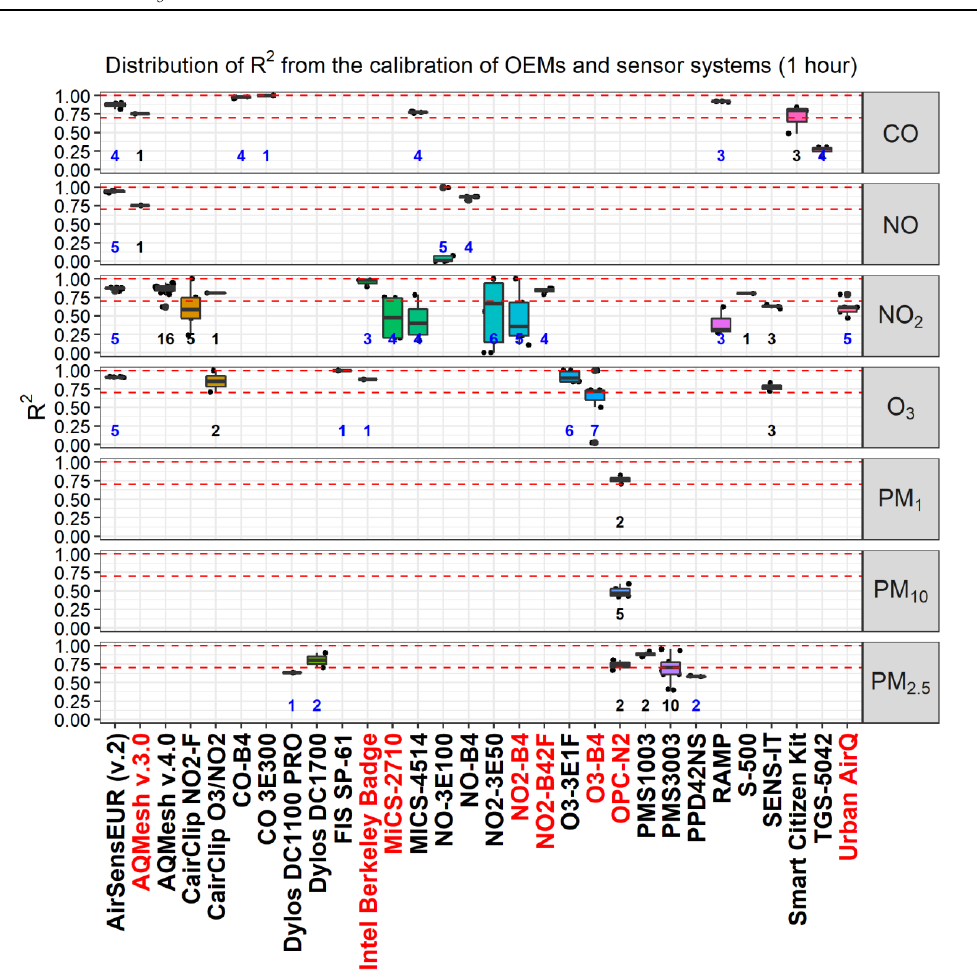
Figure A1. Distribution of R 2 for LCS hourly data against the reference for different pollutants. Dashed lines indicate the R² value of 0.7 and 1.0. Numbers in blue and black indicate the number of open source and black box records, respectively. Names of “ living ” and “ non-living ” sensors are indicated by black and red labels on the x-axis, respectively.